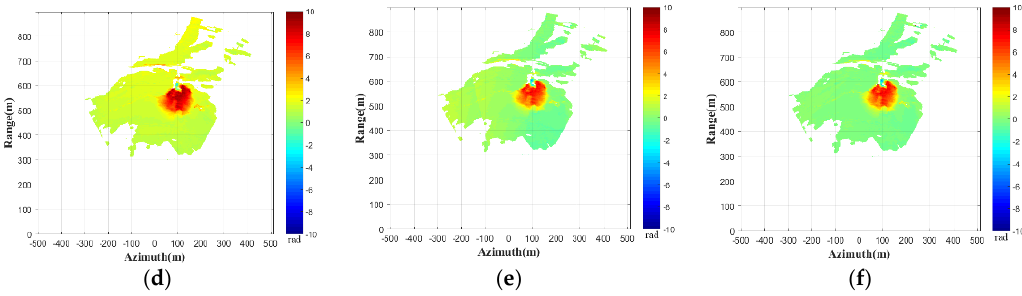
Figure 6. Experimental results: ( a ) reflectivity image; ( b ) correlation coefficient; ( c ) sub-images entropy map; ( d ) uncorrected phases; ( e ) corrected phases using linear model method; and ( f ) corrected phases using proposed method.